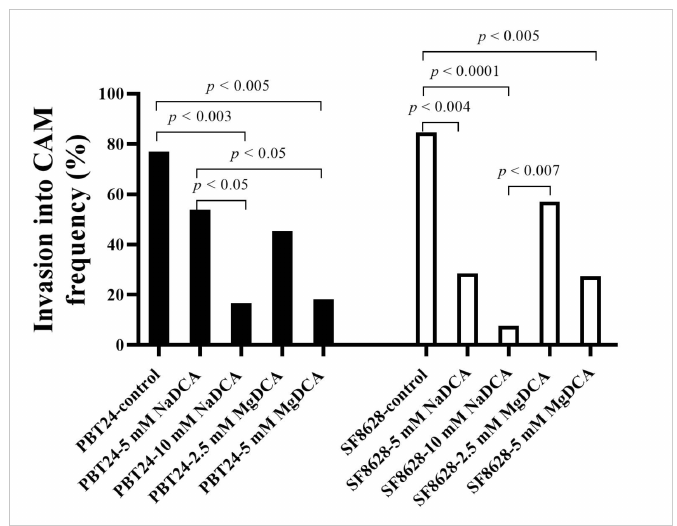
Figure 3. The invasion into CAM frequency in the PBT24 and SF8628 tumor groups. Compared to the PBT24-control, the sub-tumor CAM thickness was significantly lower in the PBT24 tumors treated with 2.5 mM MgDCA and 5 mM MgDCA. Treatment with 10 mM and 5 mM NaDCA had no significant effect on the CAM thickness under the PBT24 tumor (Table 1). Treatment with NaDCA and MgDCA doses did not significantly impact the CAM thickness under the SF8628 tumor. The strongest effect on CAM thick- ness was observed in the 5 mM MgDCA-treated group (Table 1). The number of CAM vessels under the tumor is shown in Table 1. When comparing the PBT24 tumor groups, the dose of 5 mM MgDCA had the significantly strongest in- hibitory effect on neoangiogenesis. Compared to the PBT24-control, no significant changes in the number of blood vessels were found in the other treated groups. Com- paring the number of blood vessels in the CAM mesenchyme under tumors in the SF8628-control group with the groups treated with 10 mM NaDCA and 5 mM NaDCA, we found that both doses of NaDCA significantly reduced the number of blood vessels in the membrane. The number of vessels under the tumors in the CAM of the 5 mM and 2.5 mM MgDCA-treated groups was not significantly different from that of the SF8628-control. Still, the number of vessels in both of the MgDCA-treated groups was significantly higher than in the group treated with 10 mM NaDCA. The dose of 10 mM NaDCA had the most inhibitory effect on neoangiogenesis (Table 1). 2.3. The PCNA Expression of PBT24 and SF8628 in Control and DCA-Treated Tumors Table 2 and Figure 4 show the expression data of PCNA-positive cells in the PBT24 and SF8628 tumor groups tested. The number of PCNA-positive cells in the PBT24-control tumor accounted for 63.8% of the total number of cells, while in the SF8628-control tumor, the number of PCNA-positive cells accounted for 90.8%. PCNA expression